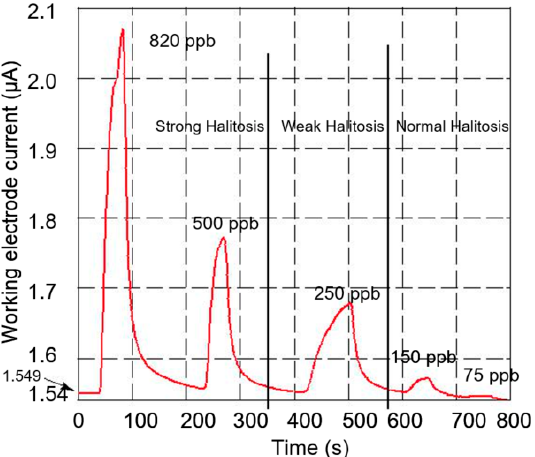
Figure 7. Working electrode current for five different H 2 S concentrations. The sensor is able to detect the entire dynamic range of H 2 S concentration that could be correlated to the concentration present in the oral breath. The background current of the sensor could be due to the interference from humidity or due to high conductivity of the electrolyte.